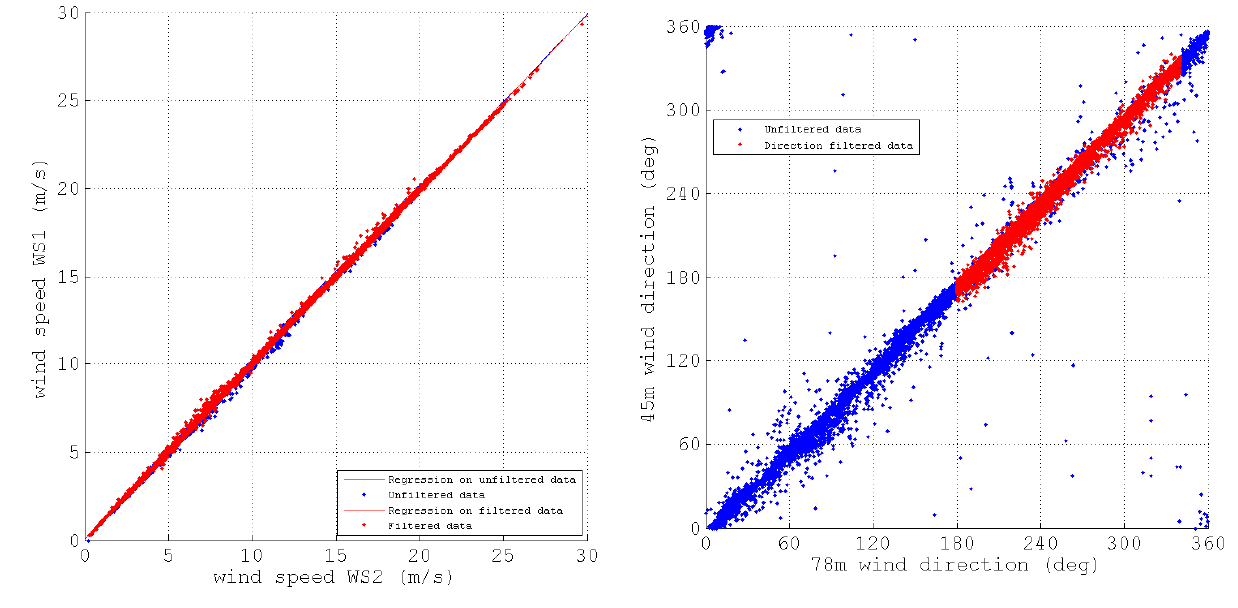
Figure 3. Mast instruments: Comparison between (a) 80 m top-mounted cup anemometers, and (b) wind vanes (78 m and 45 m). (February–May; 10 min